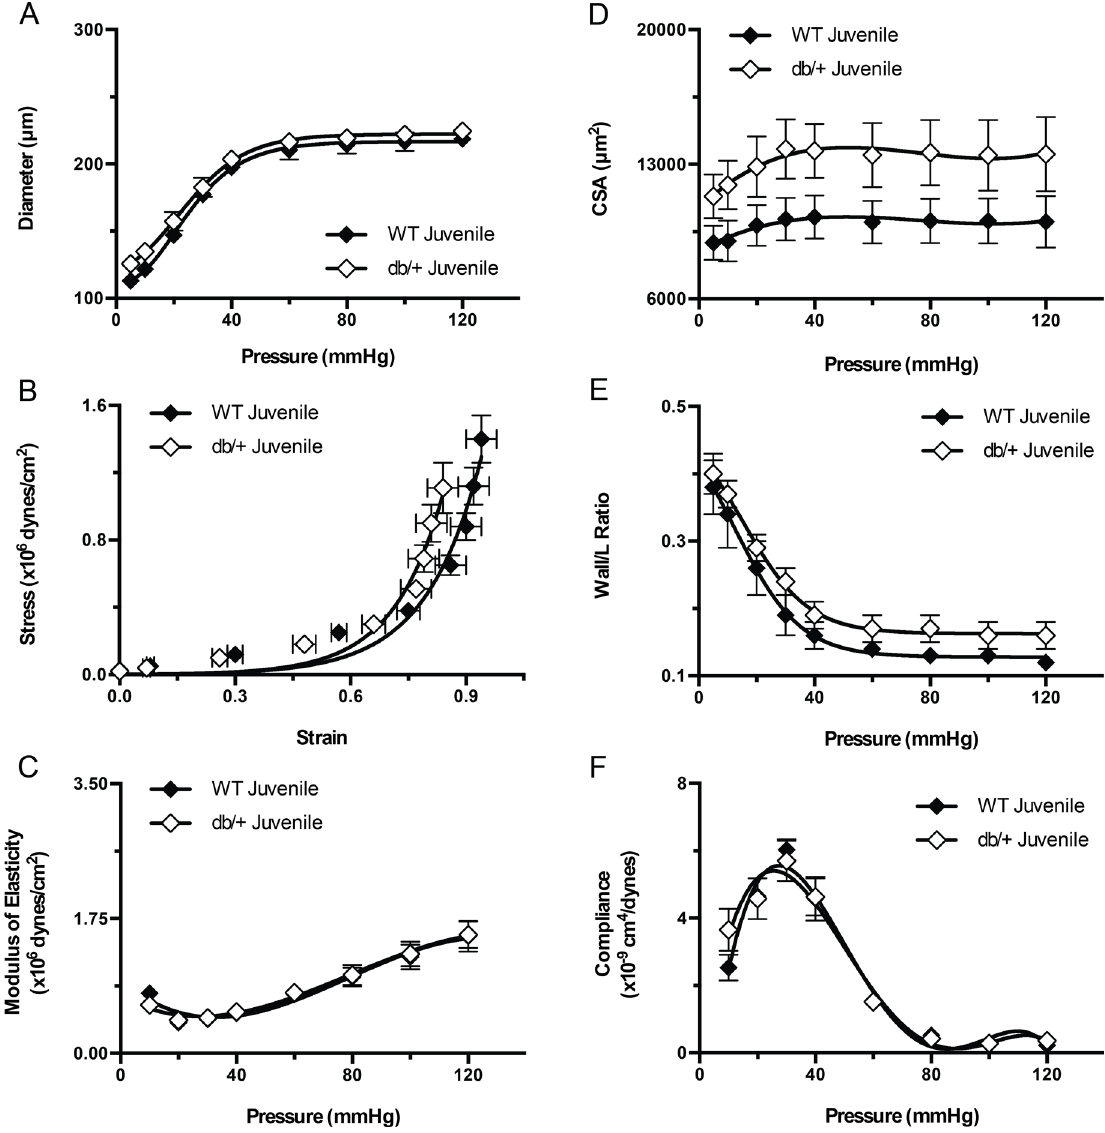
Fig 6. Effect of maternal environment on the structure and mechanical properties of mesenteric resistance arteries from juvenile (6 week-old) wild type (WT) male offspring of WT-control or Lepr db/+ (db/+) dams. (A) Pressure-diameter curves of blood vessels kept under passive conditions. (B) Strain-stress relationship curves of mesenteric arteries kept under passive conditions at different intravascular pressures. (C) Elastic moduli of mesenteric arteries kept under passive conditions at different intravascular pressures. (D) Cross sectional area (CSA) of the vascular wall in mesenteric arteries kept under passive conditions at different intravascular pressures. (E) Vascular wall to intravascular lumen ratio of mesenteric arteries kept under passive conditions at different intravascular pressures. (F) Compliance of mesenteric arteries kept under passive conditions at different intravascular pressures. Data are means ± SEM of n = 5 number of animals (vessels) per treatment group